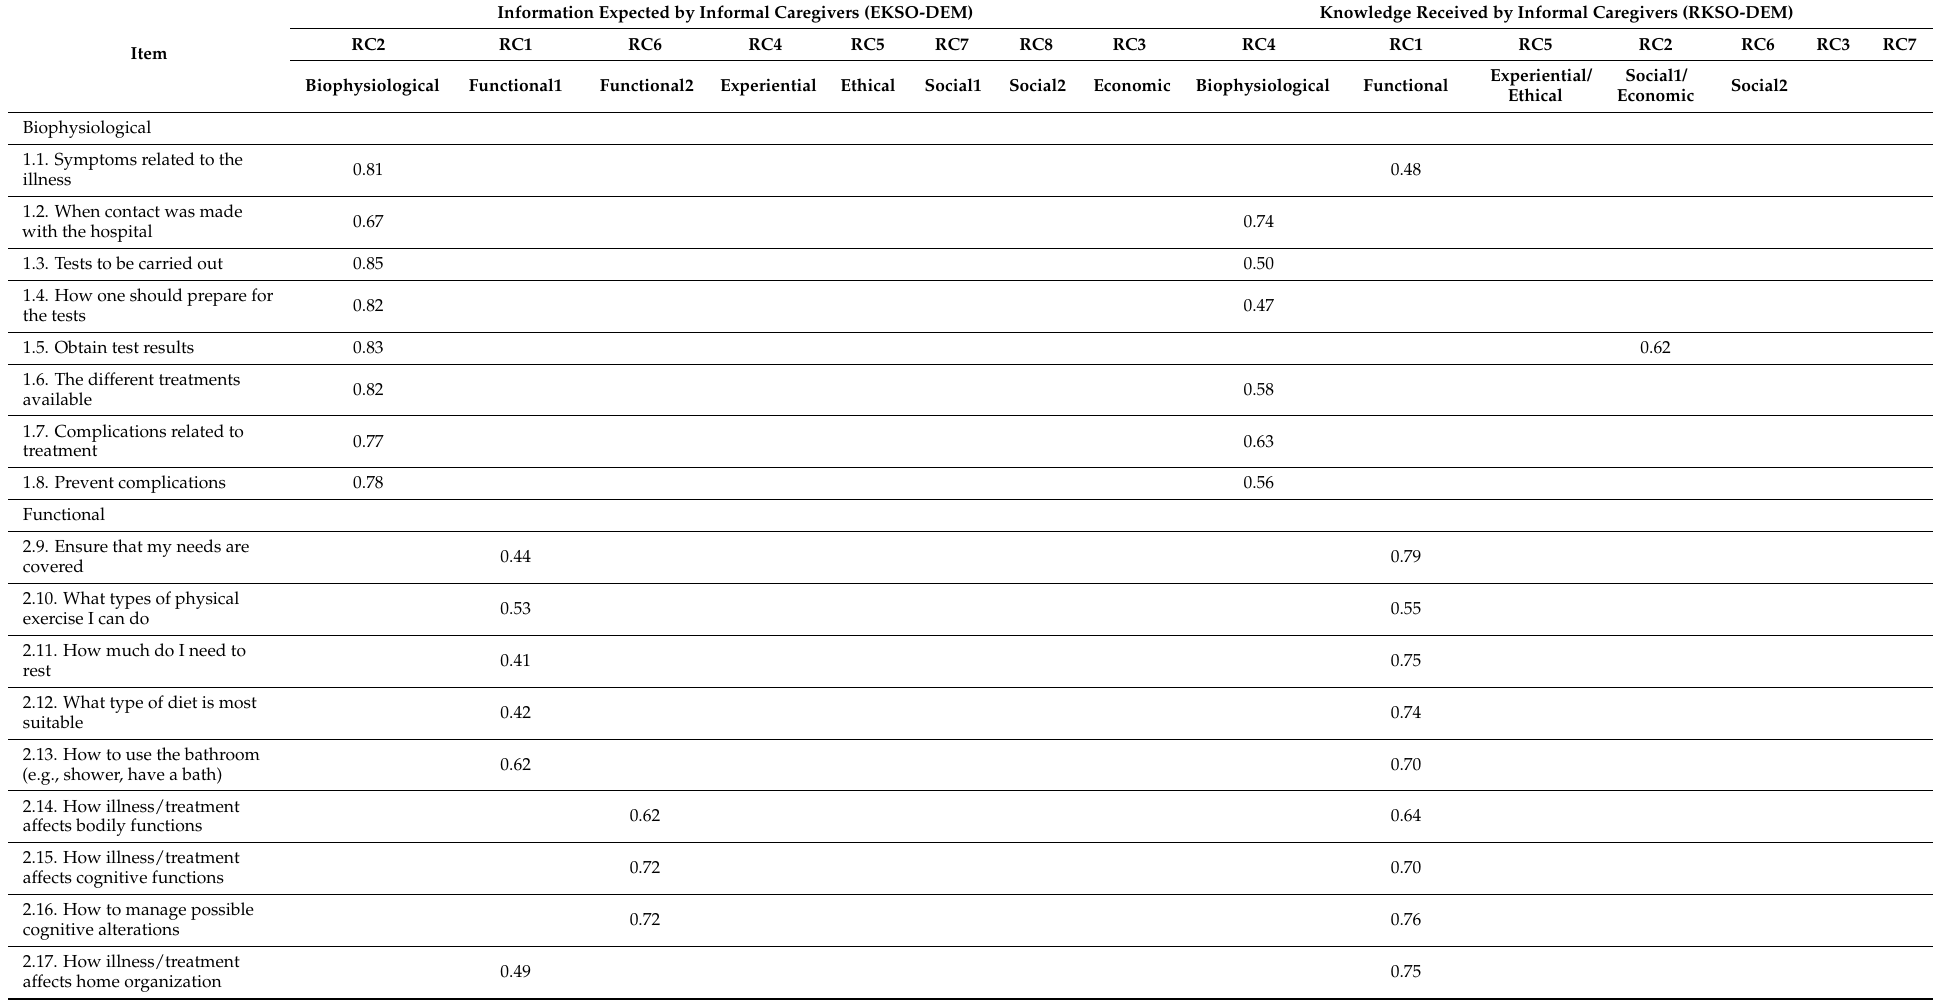
Table 3. Main components analysis with varimax rotation